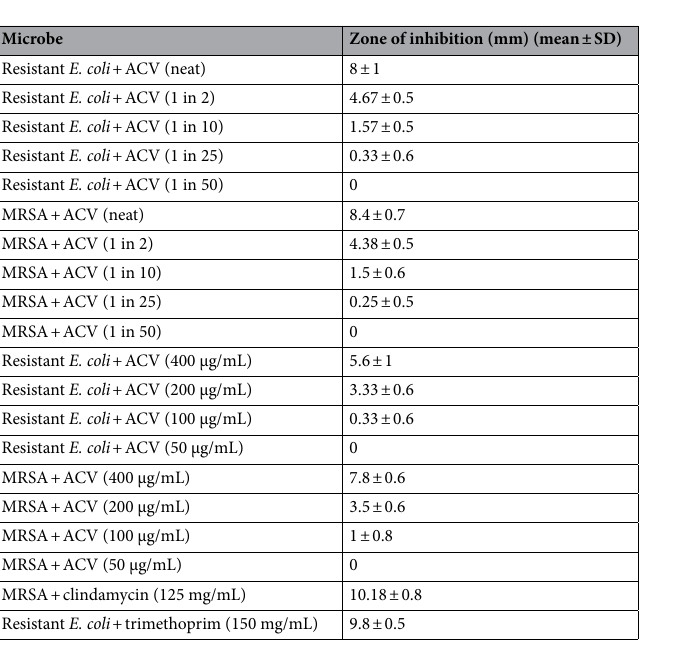
Table 1. Microbe growth inhibition zone measurements after exposure to ACV and antibiotics. E.coli or MRSA were inoculated onto MHA plates and co-cultured with different concentrations of ACV or antibiotics at 37° C for 24 h. After which time the effect on microbial growth was measured in mm by the diameter of the inhibition produced. Data is presented as mean ± SD of three similar experiments.